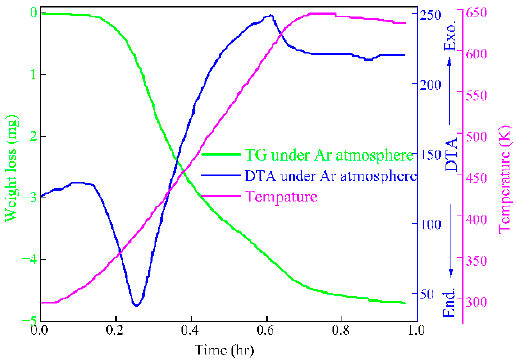
Figure 2. TG-DTA curves of sample prepared by heating the gel at 773 K under Ar atmosphere. Table 2. Weight losses of sample prepared by heating the gel at 773–973 K. Temperature